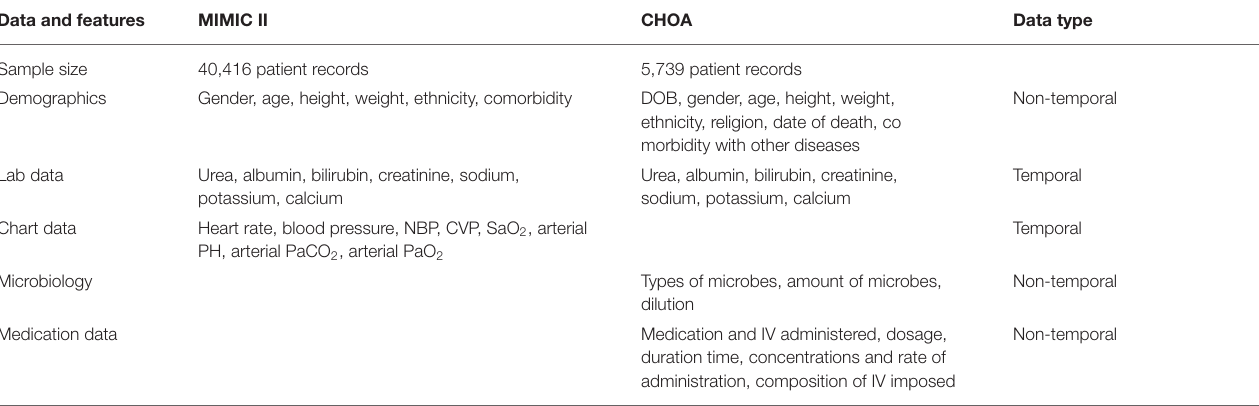
TABLE 1 | Summary of Multi-parameter Intelligent Monitoring in Intensive Care (MIMIC) and Children’s Healthcare of Atlanta (CHOA)